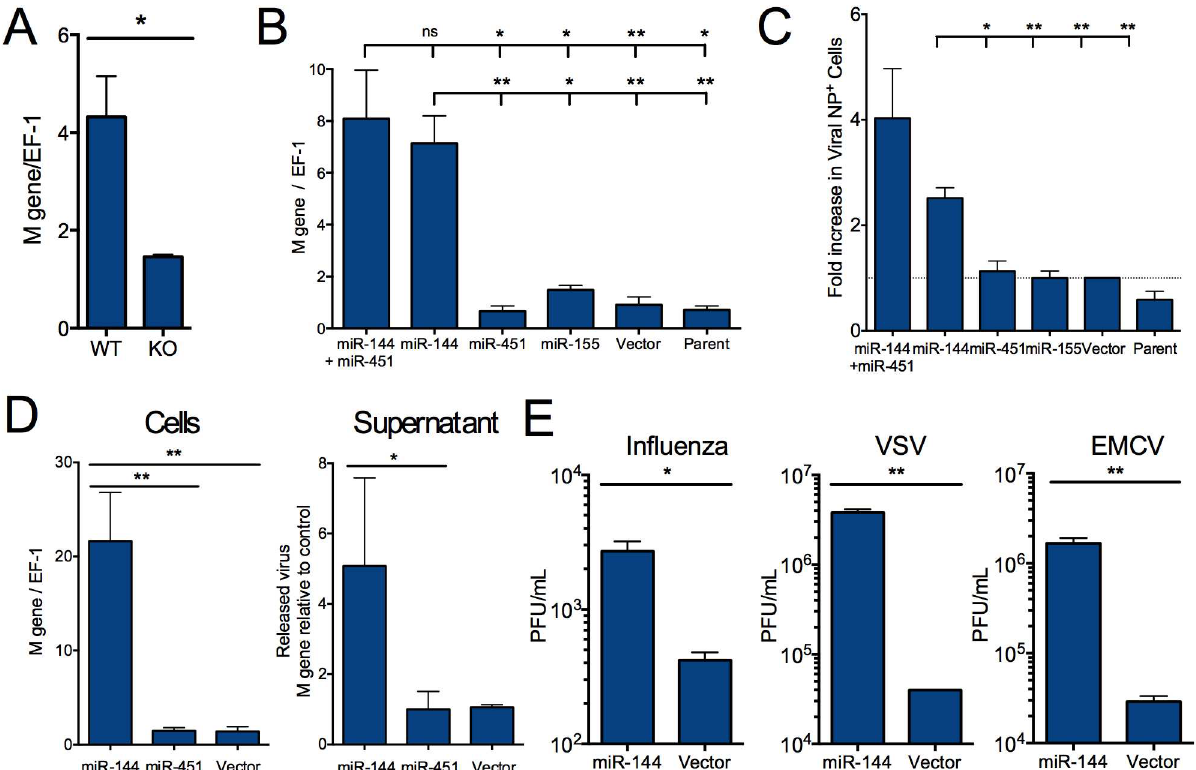
Fig 2. miR-144impairs control of viral replication by murine lung epithelial cells. ( A ) miR-144/451 KO or WT lung epithelial cells were infected with influenza virus. Mean viral load ± SEM at 24 h was quantified by qRT-PCR of viral M geneand normalizedto host EF-1 ( n = 3). * p < 0.05. ** p < 0.01,NS, not significant.( B ) TC-1 cells were stably transduced with retrovirus expressingGFP along with miR-451+miR- 144, miR-144, miR-451, miR-155, or retroviral vector alone and comparedwith untransduced (parent) cells. Viral load in influenza-infected cells was quantified as in A . Means ± SEM for 3–7 independentexperiments are shown and p-values calculatedfor miR-144+miR-451and miR-144-expressingcells relativeto each other cell line. * p < 0.05. ** p < 0.01,NS, not significant.( C ) TC-1 cells were infected as described in B and the mean percentage ± SEM of influenzaNP + cells quantifiedby flow cytometry ( n = 4–9 independentexperiments); p-values were calculatedfor cells expressingmiR-144alone relativeto each other control cell line. ( D ) Primary mouse lung epithelialtype I cells (LET1) were immortalized while being transduced with lentivirus expressingmiR-144,miR-451, or vector alone. Viral load in influenza-infected cells ( n = 6–9) or releasedinto supernatants ( n = 2–7) was measuredas describedin B , and means ± SEM are shown. ( E ) Infectiousvirus in the supernatants of LET1 cells infected with influenza, EMCV, or VSV measuredby plaqueassay. Means ± SEM are shown for 3 independent experiments performed in duplicate.A similar increase in viral load was observedwhen LET1 cells expressingmiR-144were compared with cells expressingmiR-451. * p < 0.05, ** p < 0.01,ns = not